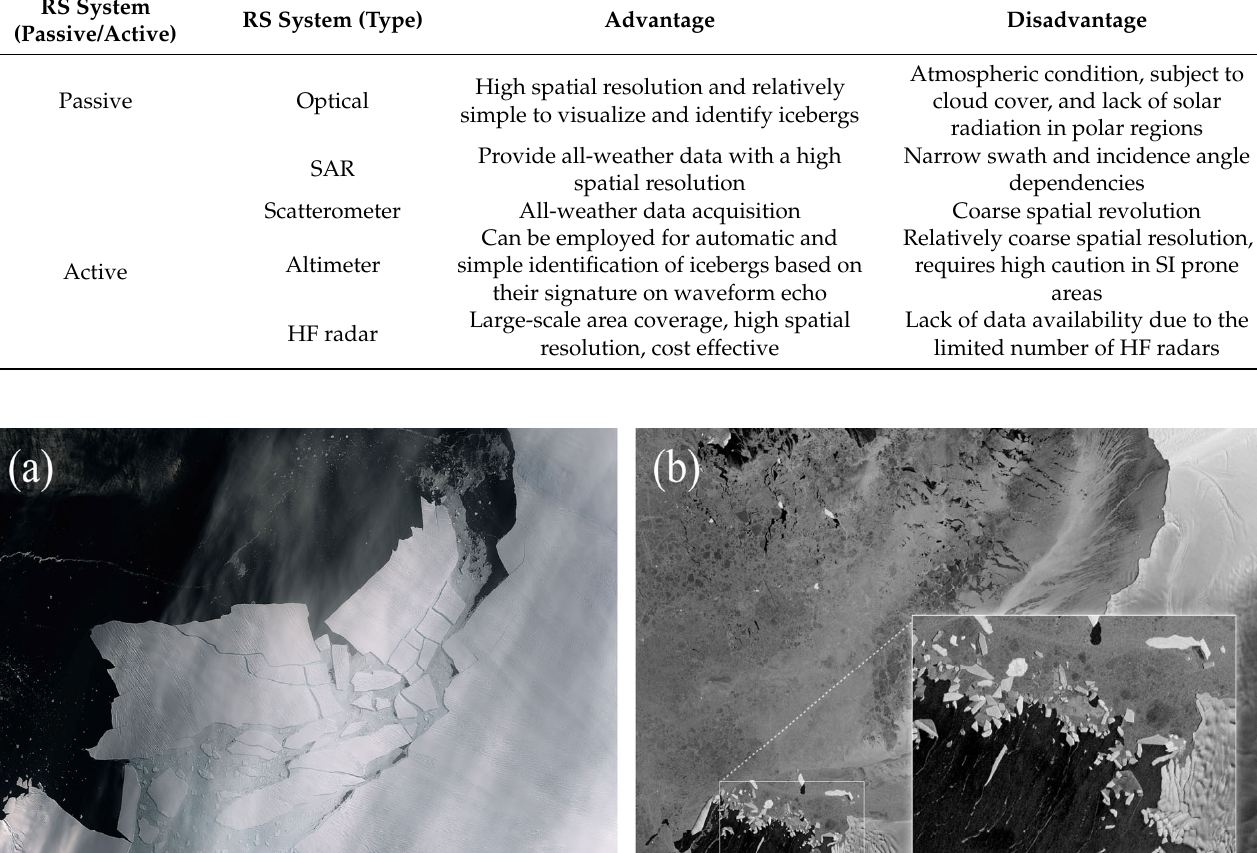
Table 1. Different RS systems for iceberg studies along with their advantages and disadvantages.